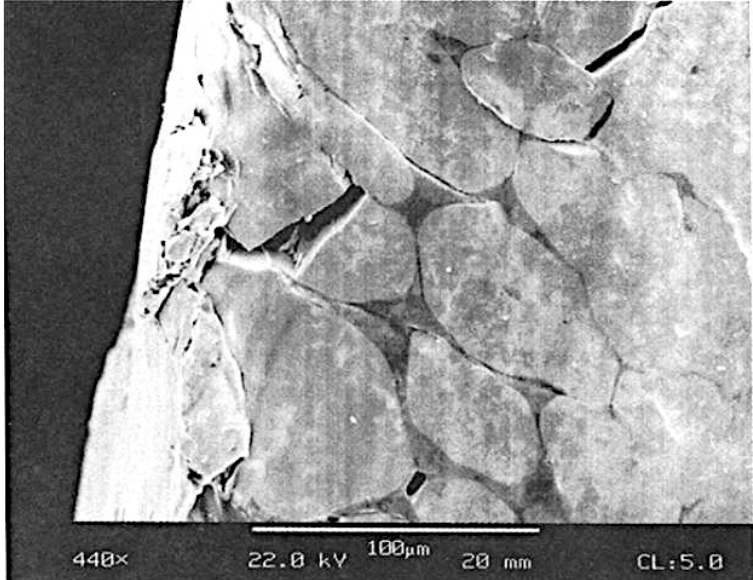
Figure 17. Microcracks at W-W grain boundaries in shear band region